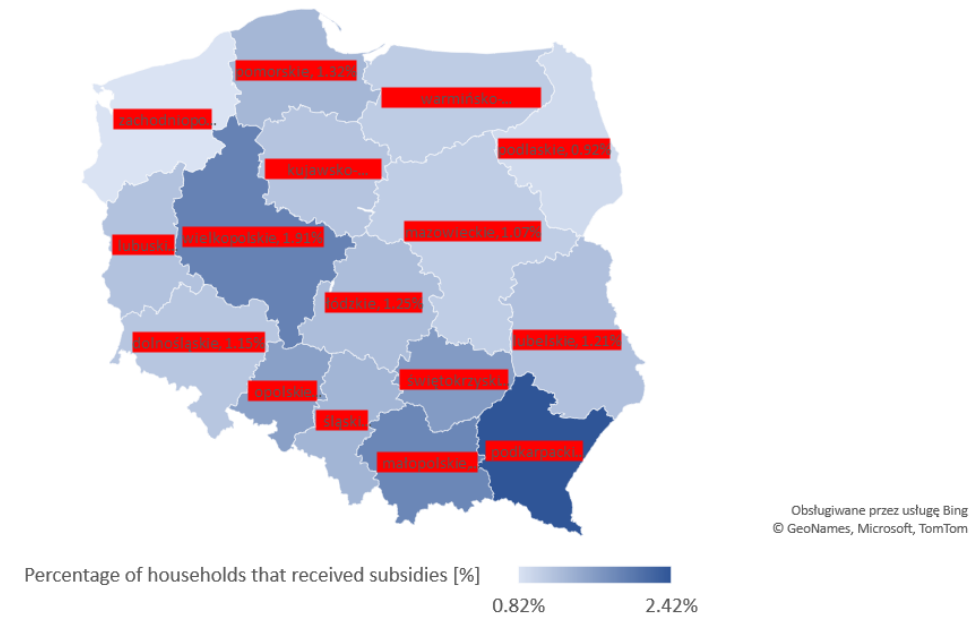
Figure 4. Percentage of households that received subsidies.